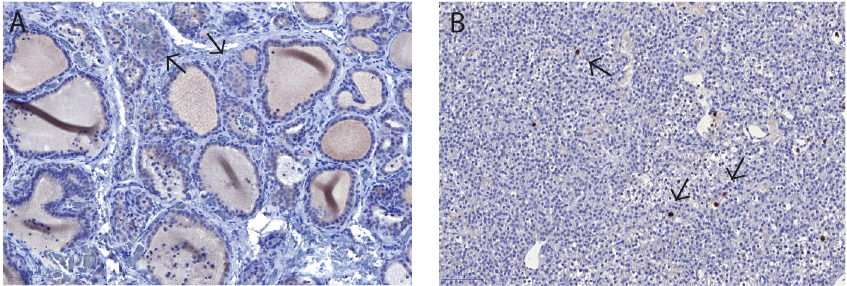
Figure 11. Immunohistochemical evaluation of the GD1a expression of the human thyroid ( A ) and parathyroid gland ( B ). ( A ) Weak cytoplasmatic staining was found in the follicular cells and c-cells (arrows) in two of the thyroid glands. ( B ) Demonstrates single positive cells with high expression of GD1a on the cell surface evenly distributed in the parathyroid tissue